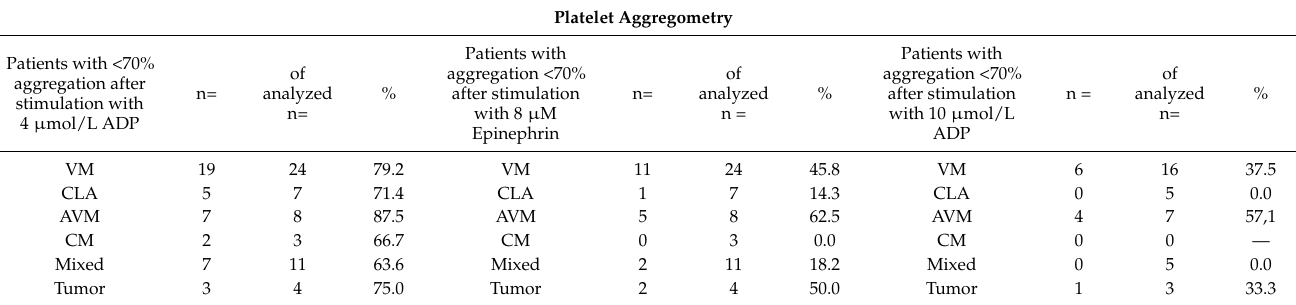
Table 5. Alterations in thrombocyte aggregation specified by disease. Platelet